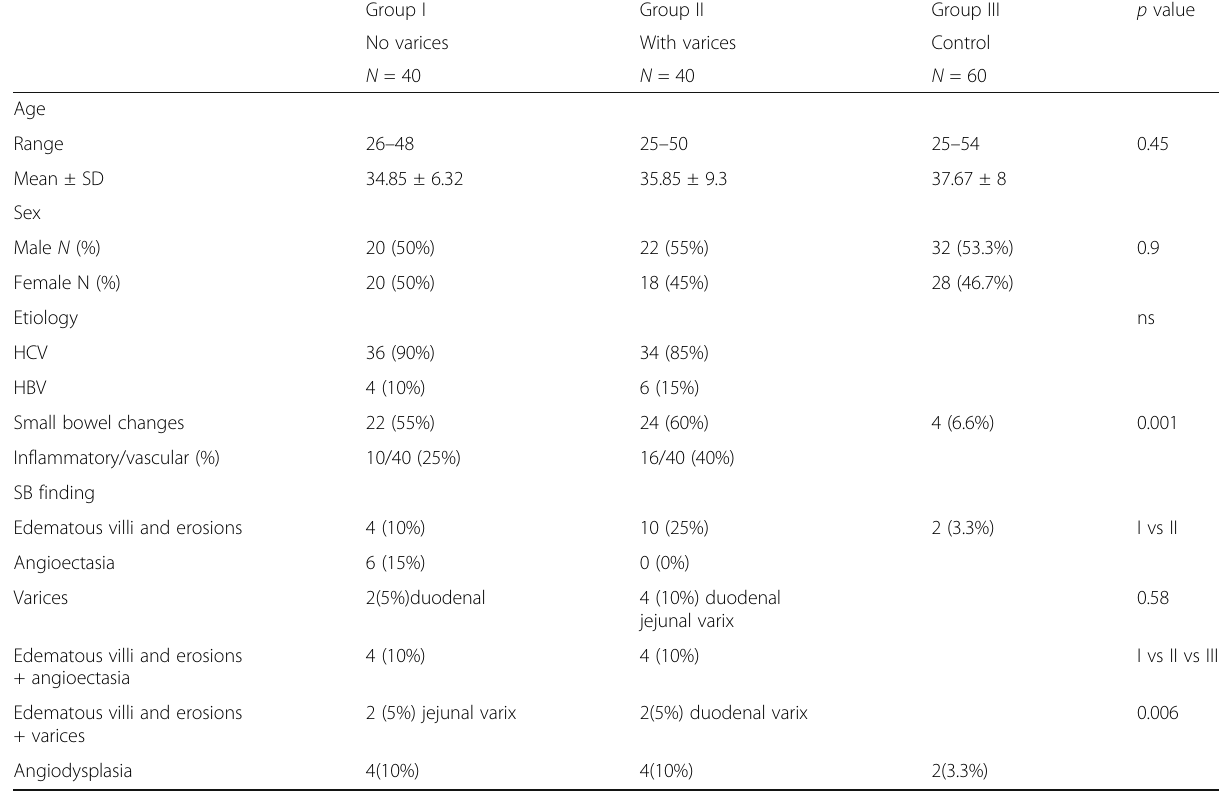
Table 1 Characteristics and small bowel changes in studied